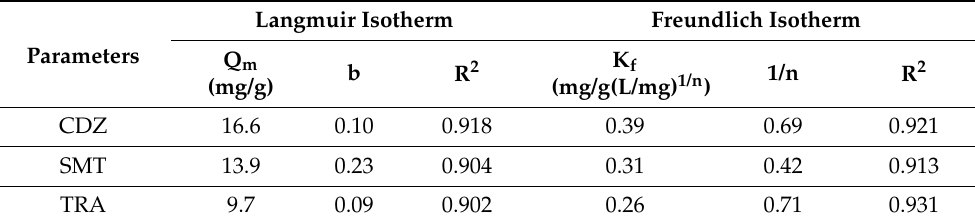
Table 6. Langmuir and Freundlich isotherms study for CBZ, AMT and TRA removal by biochar. Langmuir Isotherm Freundlich Parameters